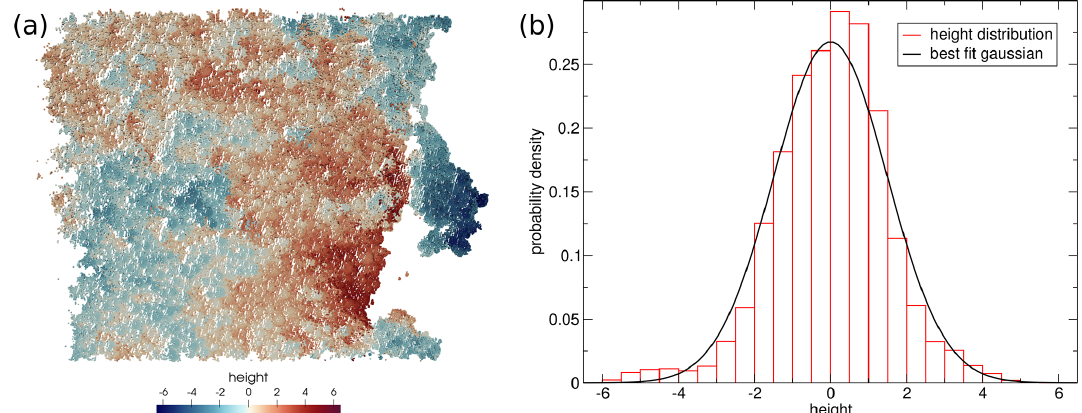
Figure 7. Distribution of heights of a simulated fracture surface above a “best-fit” plane. Data are taken from a model with σ 2 = 5MPa and σ 3 = 0MPa. (a) Map view of the surface colored by height above the “best-fit” plane. (b) Probability density of heights and fitted normal